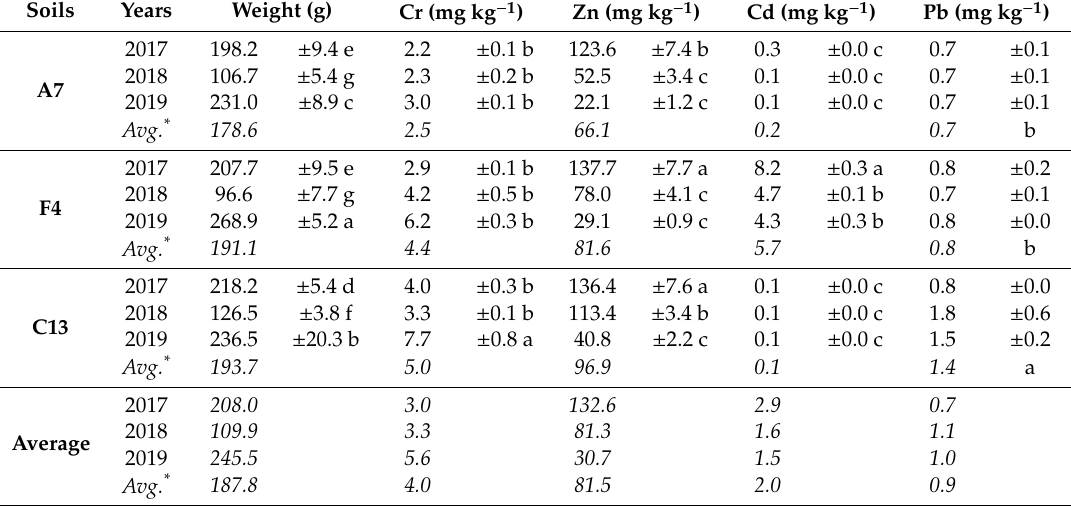
Table 2. Biomass production expressed in g dry weight (d.w.) mesocosm − 1 ± standard deviation